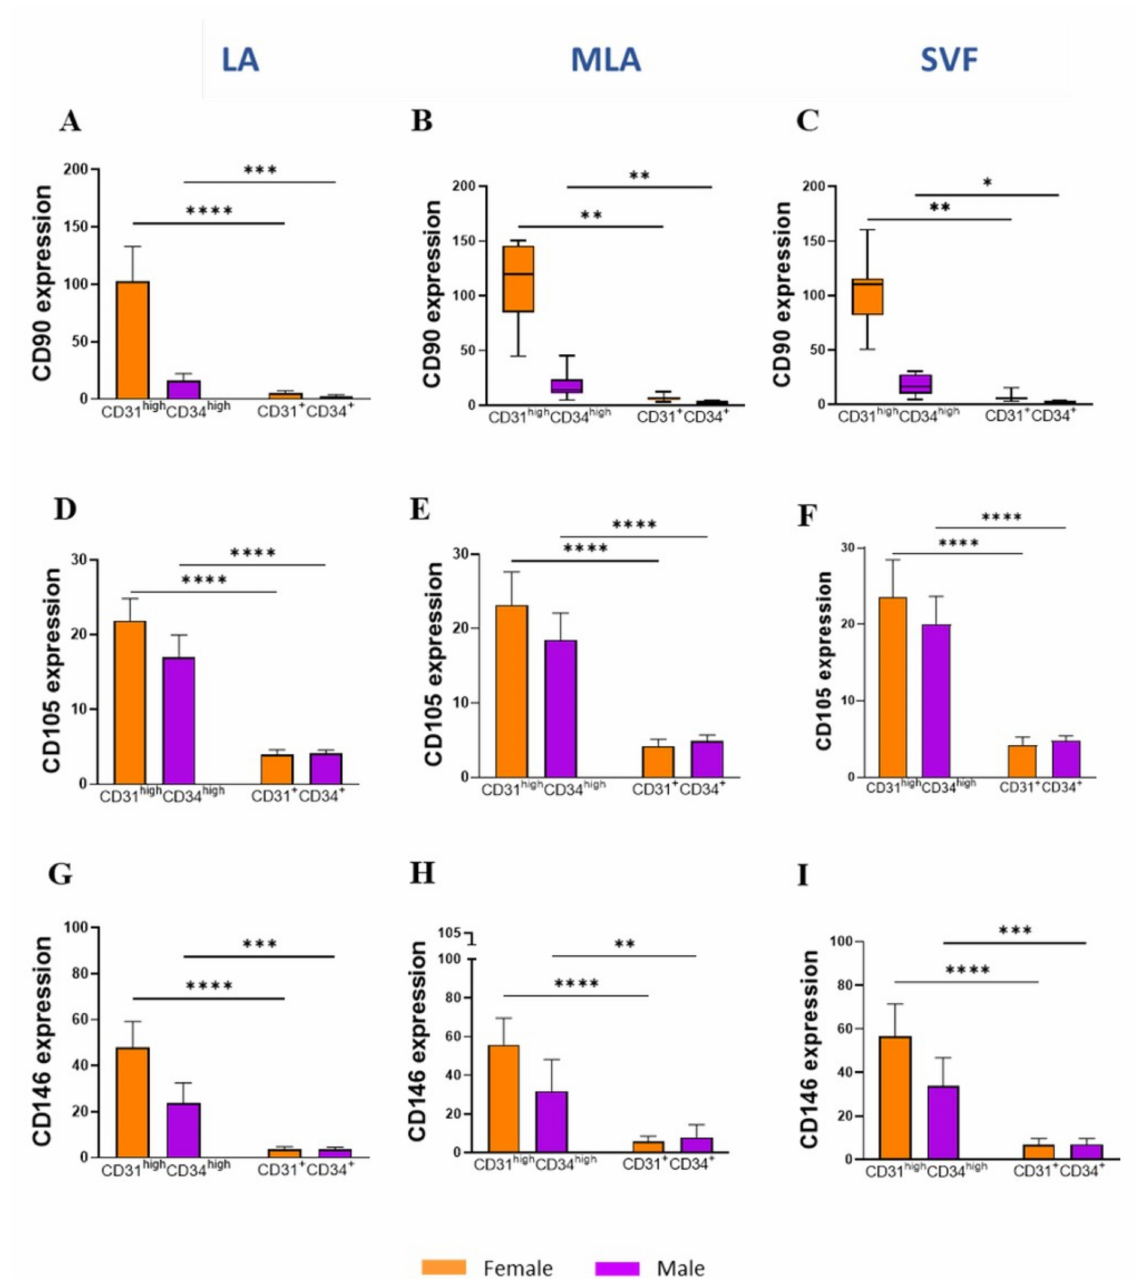
Figure 7. Expression of the mesenchymal stem/stromal cell–characteristic markers in EP subpopulations. Differences in the expression of CD90 ( A – C ), CD105 ( D – F ) and CD146 ( G – I ) markers between CD31 high CD34 high EP and CD31 + CD34 + EP from LA (left panels), MLA (middle panels) and SVF samples (right panels) in female and male patients. The geometric mean fluorescence intensity (geo MFI) data are expressed as bars with SD ( A , D – I ) or box and whiskers ( B , C ) of 8 patients. Statistical analysis was performed using ordinary one–way ANOVA with Sidak’s multiple comparison test ( A , D – I ) or Friedman multiple comparisons test ( B , C ). p -values: (*) p < 0.05; (**) p < 0.01; (***) p < 0.001; (****) p <